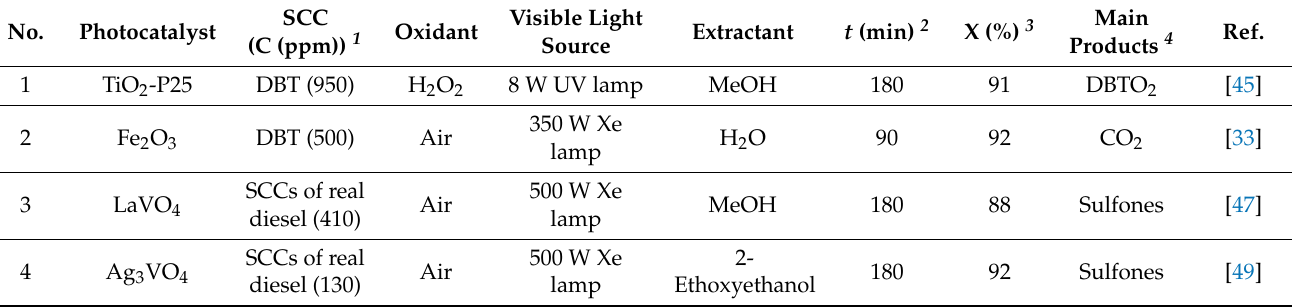
Table 1. Activity of unmodified materials in